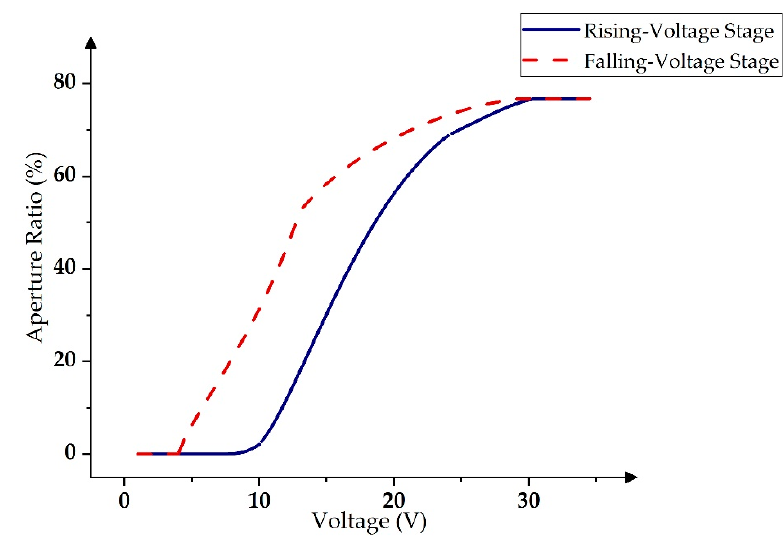
Figure 3. Rising-voltage stage and falling-voltage stage of the hysteresis curve in EWDs.